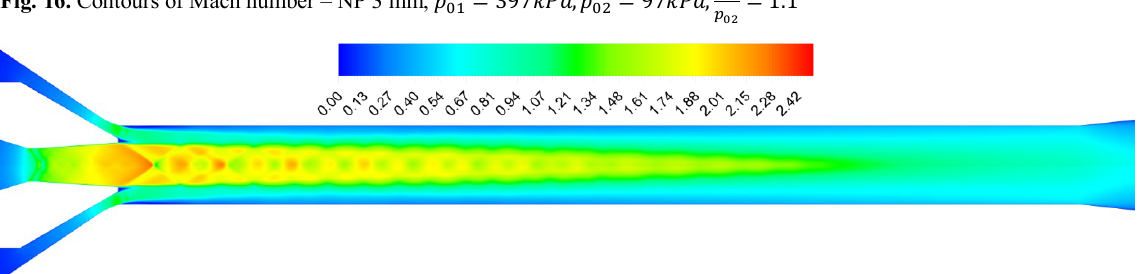
Fig. 16. Contours of Mach number – NP 3 mm, 𝑝